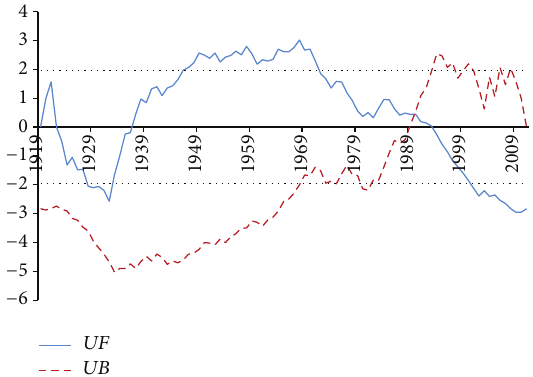
Figure 4: Mann-Kendall test statistics ( 𝑈𝐹 and 𝑈𝐵 values) calcu- lated from annual runoff data at the Huaxian